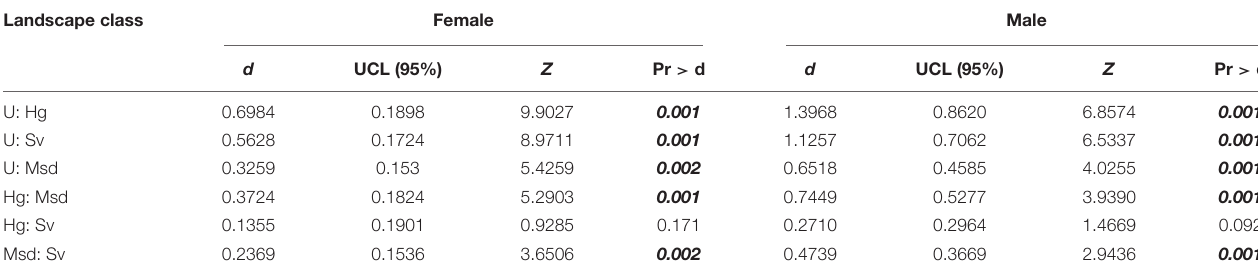
TABLE 3 | Results of pairwise comparison of thorax size of T. dimidiata among landscapes Z and P are based on 2,500 random permutations. Landscape class